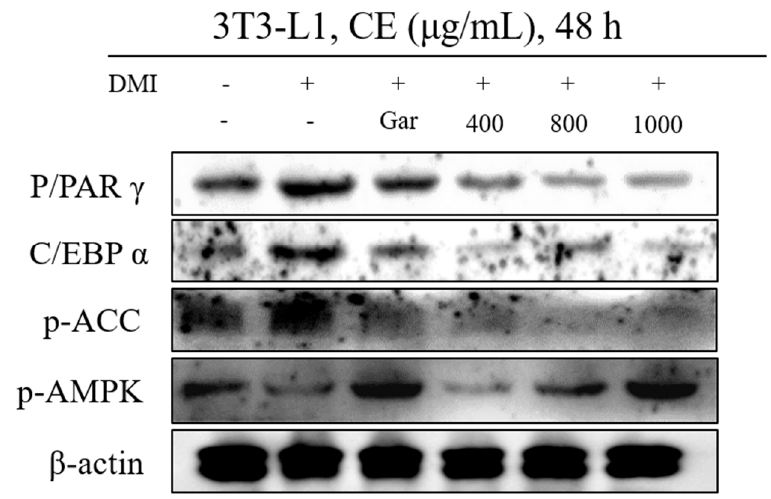
Figure 3. The anethanol extract of Cheongchunchal (CE; 200, 400, 800, and 1000 μ g/mL) or Garcinia (Gar, 200 μ g/mL) effects on the expression of adipocyte differentiation-related protein. The expression of peroxisome proliferator-activated receptors (PPAR γ ), C/EBP α , p-ACC, p-AMPK, and β -actin in 3T3-L1 preadipocytes was analyzed by Western blot analysis.